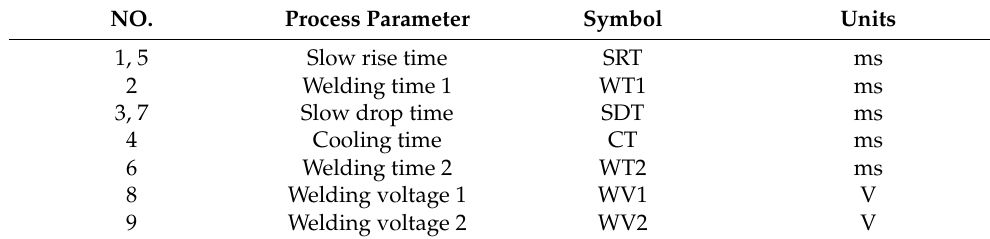
Table 1. Meaning of voltage waveform segmentation.